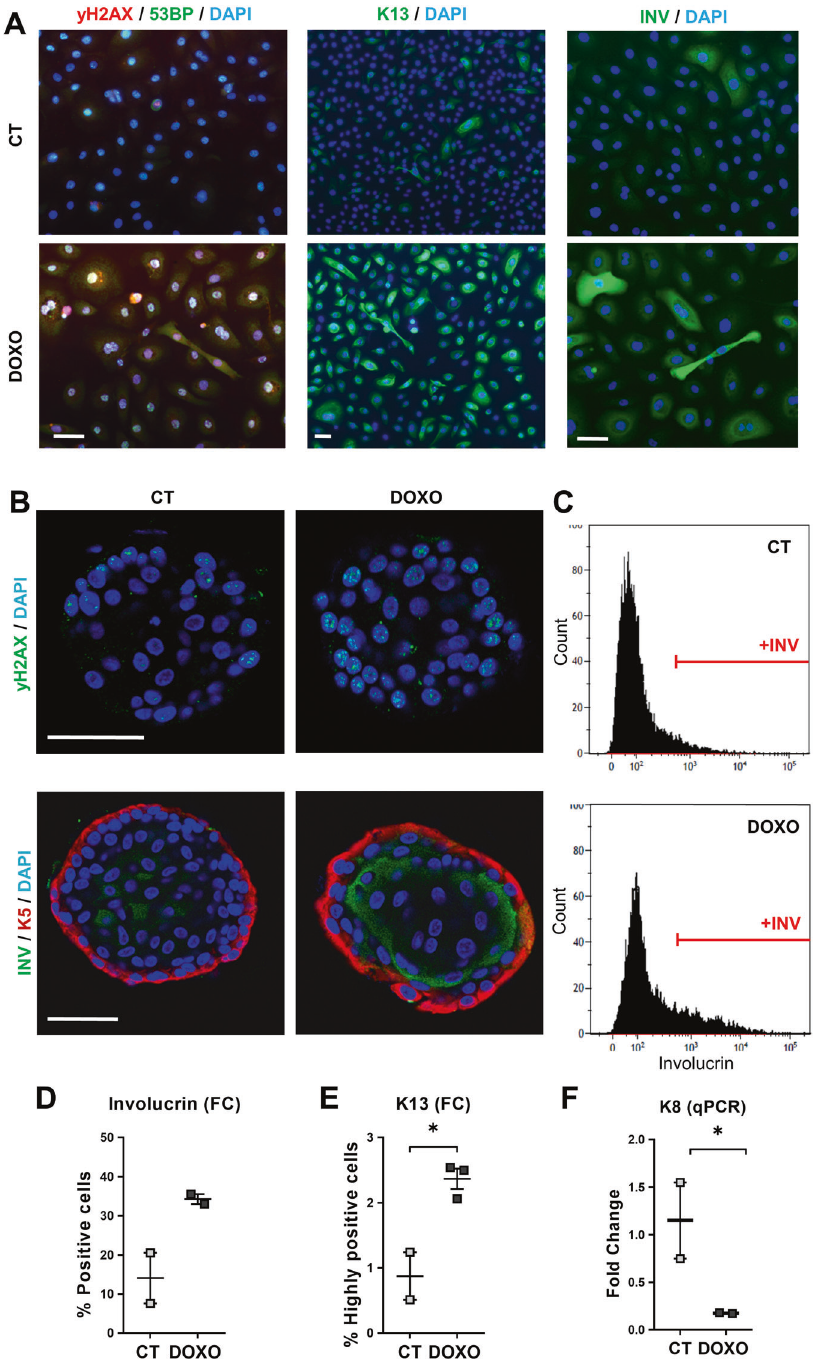
Fig. 2 Doxorubicin induces squamous differentiation in human lung epithelial cells in a serum-free lung-adapted medium and in organoid reconstructions. A Human primary lung epithelial cells isolated and cultured in lung-adapted medium were treated for 48 h with the dimethyl sulfoxide vehicle (CT) or with 0.5 μ M Doxorubicin (DOXO), as indicated. Immuno fl uorescence for 53BP (green) and γ H2AX (red), for K13 (green), or for involucrin (green), as indicated. Blue is nuclear DNA by DAPI; scale bar, 50 μ m. Representative of two independent experiments with similar results. B – F Airway lung organoids (AOs) in organoid expansion medium were treated with dimethyl sulfoxide (CT) or with 0.25 μ M Doxorubicin (DOXO) for 24 h ( C , D , F ) or 48 h ( B , E ), as indicated. B Immuno fl uorescence confocal images of AOs treated as indicated and stained for γ H2AX (top; green) or for involucrin (bottom; green) and K5 (red). Scale bar, 50 μ m. Blue is nuclear DNA by DAPI. C Representative fl ow cytometry analyses for the differentiation marker involucrin ( + INV, positive cells). D Percent of involucrin positive cells by fl ow cytometry. E Percent of keratin K13 positive cells by fl ow cytometry. F mRNA fold change of keratin K8 by qPCR. Positive cells by fl ow cytometry were gated according to negative isotype antibody control. Data are mean ± SEM of two or three replicate samples of two independent experiments from two different human individual. * p ≤ 0.05, p for + INV = 0.09.